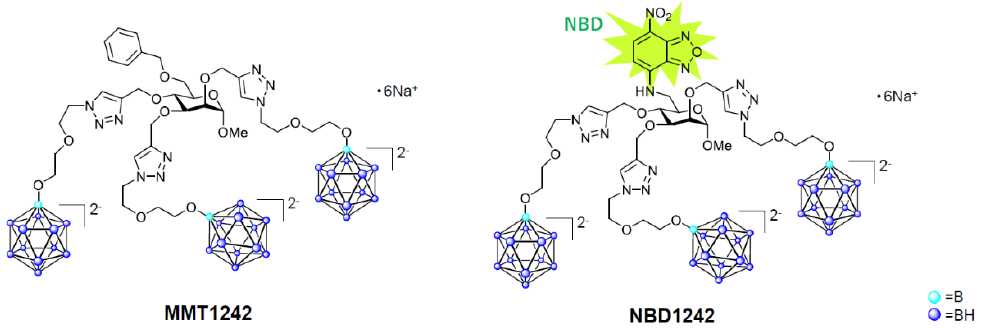
Figure 3. The chemical structures of MMT1242 and NBD1242.